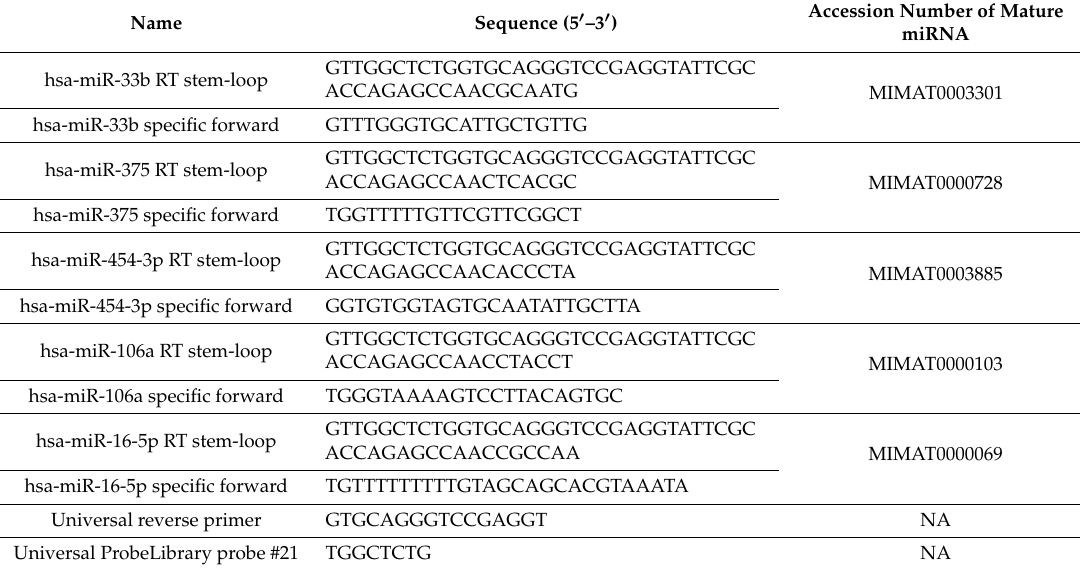
Table 4. Primer sequences used for